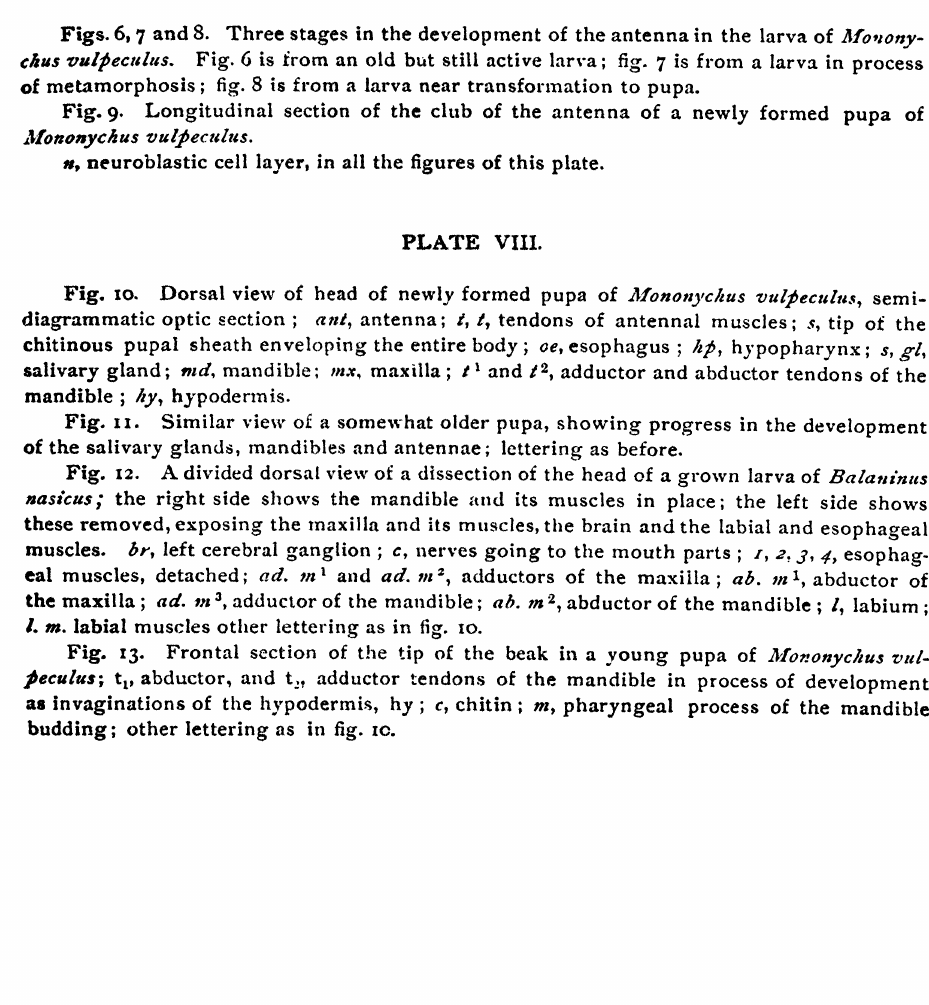
Fig. I. Adult beetle, Balaninus nasicus Say. Fig. 2. Full grown larva of same. Fig. 3. Dorsal view of head end of pre-pupa of Arononychus vuljeculus Fabricius, Fig. 4- Ventral view of mouth parts, antennae and rostrum of same. Fig. 5. Similar view of 2alanlnus nasicus.